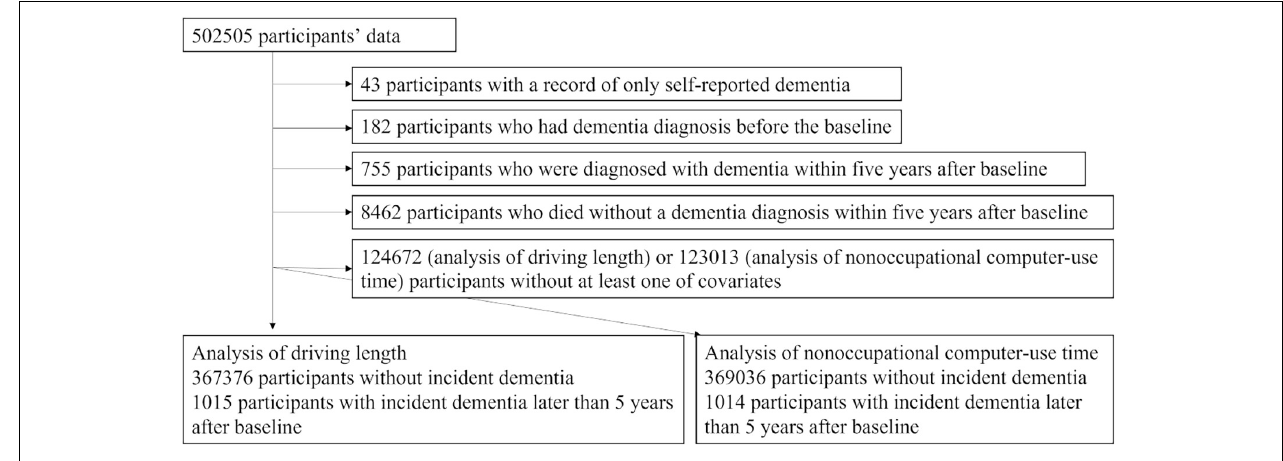
FIGURE 1 | A flowchart of the study exclusion